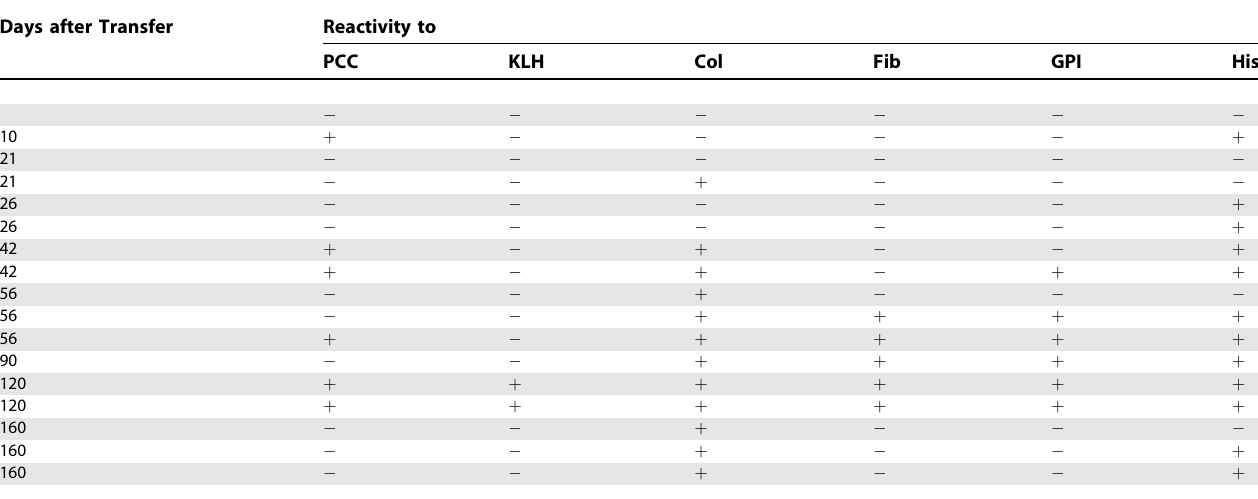
Table 1 Purified Antigens Separated by SDS-PAGE and Transferred to Nitrocellulose Membranes Were Probed with Serum Samples (1:1,000 Dilution) from Mice Bled Various Days after T cell Transfer Days after